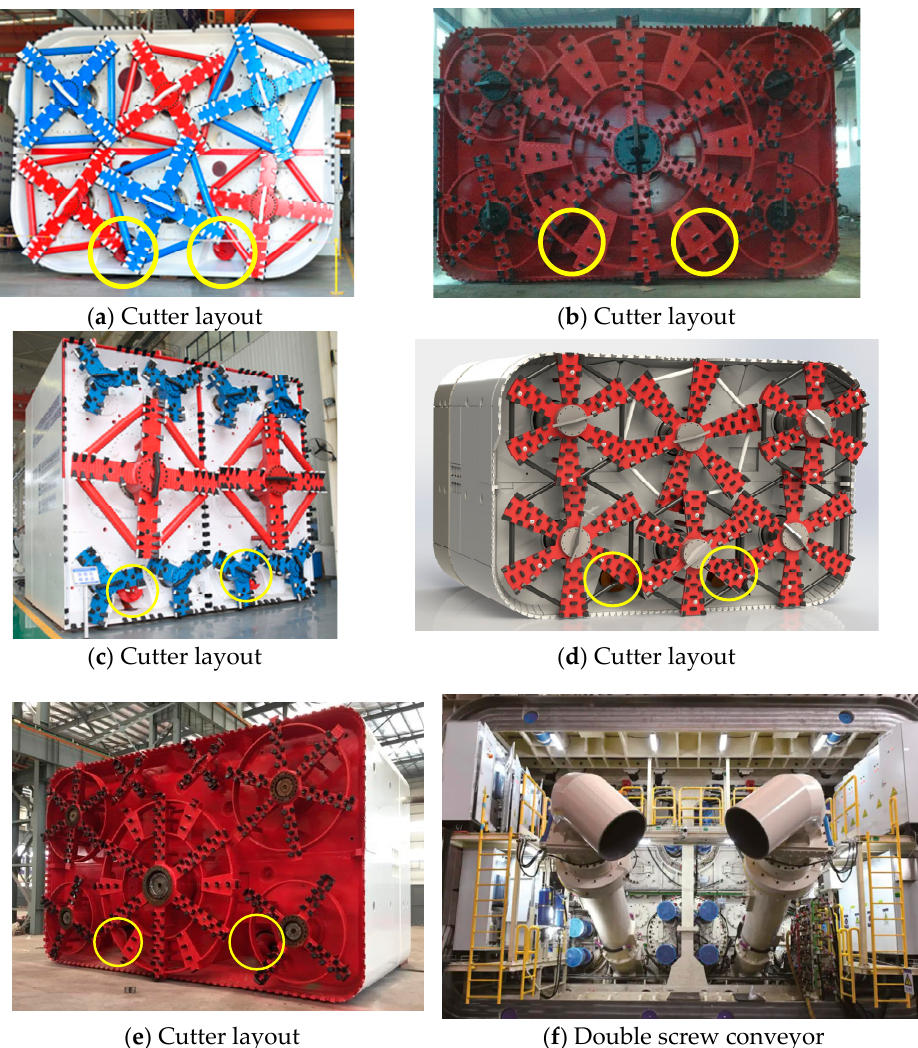
Figure 1. Typical box tunneling machine with multiple cutter heads and double-screw conveyors.